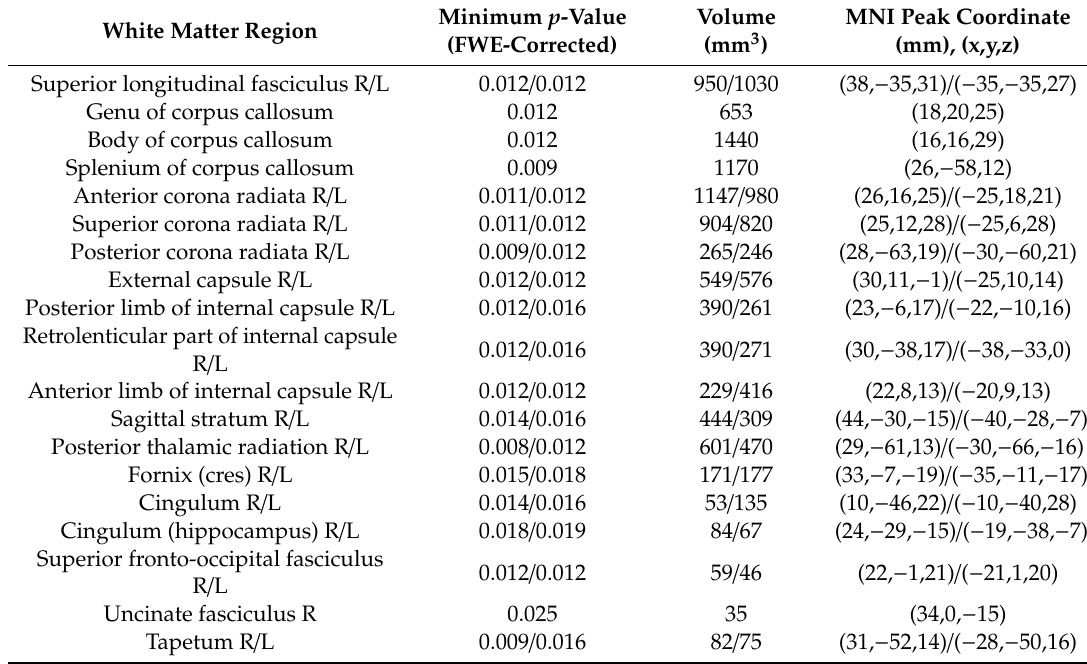
Table A8. White matter regions from the ICBM-DTI-81 White Matter Atlas for which significant decreased MD values were found in CM compared to EM including the duration of the migraine, presence of aura and medication overuse headache as covariates.